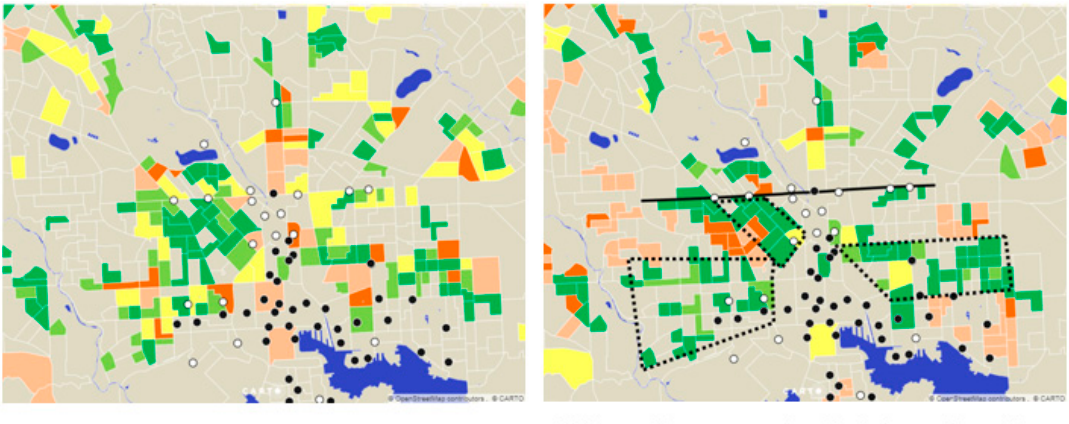
Figure 6. Infrastructure Prioritization Schematic. Orange = infrastructure or traffic calming priority area, green = bike share ready area, yellow = secondary priority area.